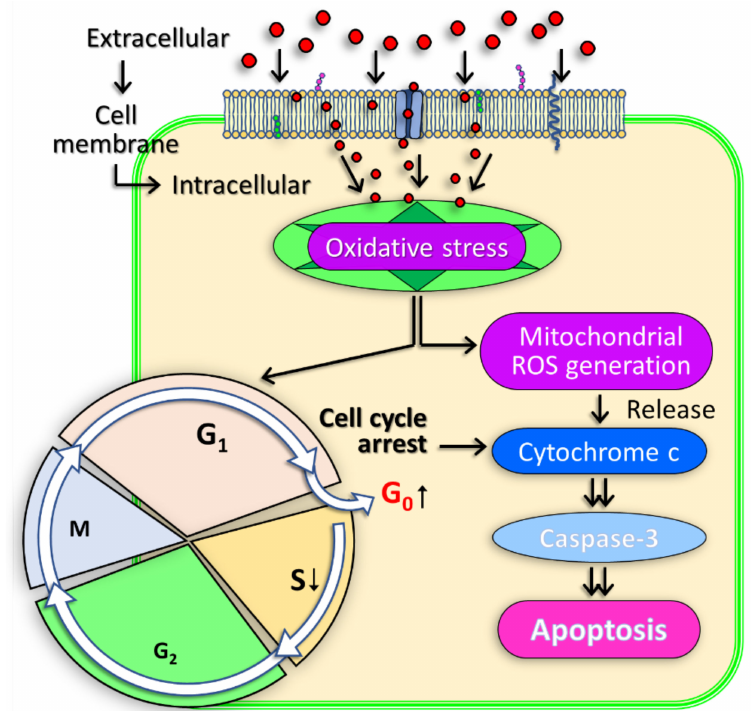
Figure 5. Proposed oxidative stress pathways involved in the PAM induction of apoptosis in bladder cancer